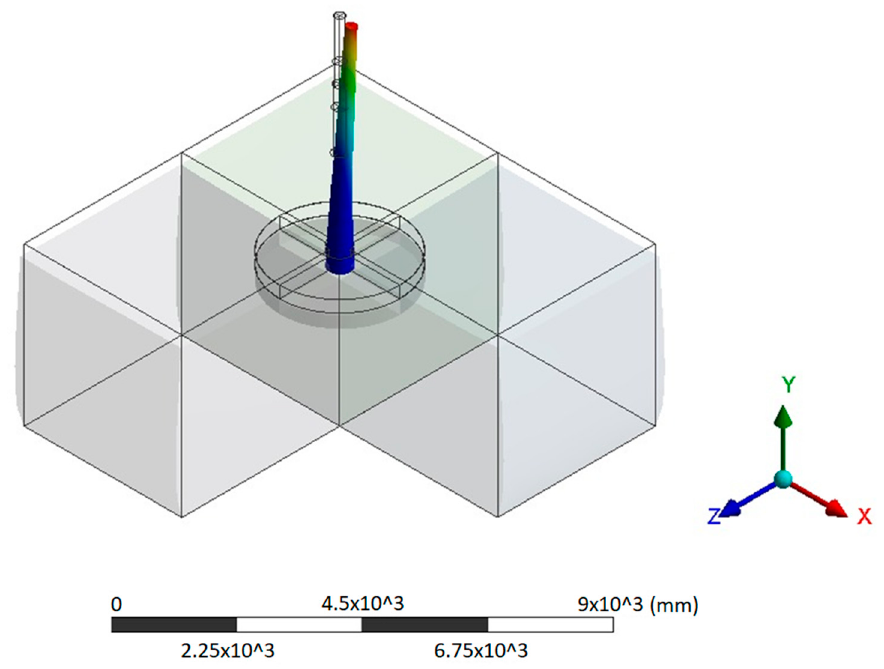
Figure 2. Example of deflection of the trunk (colored) and root plate (shadow) obtained in the numerical simulation.